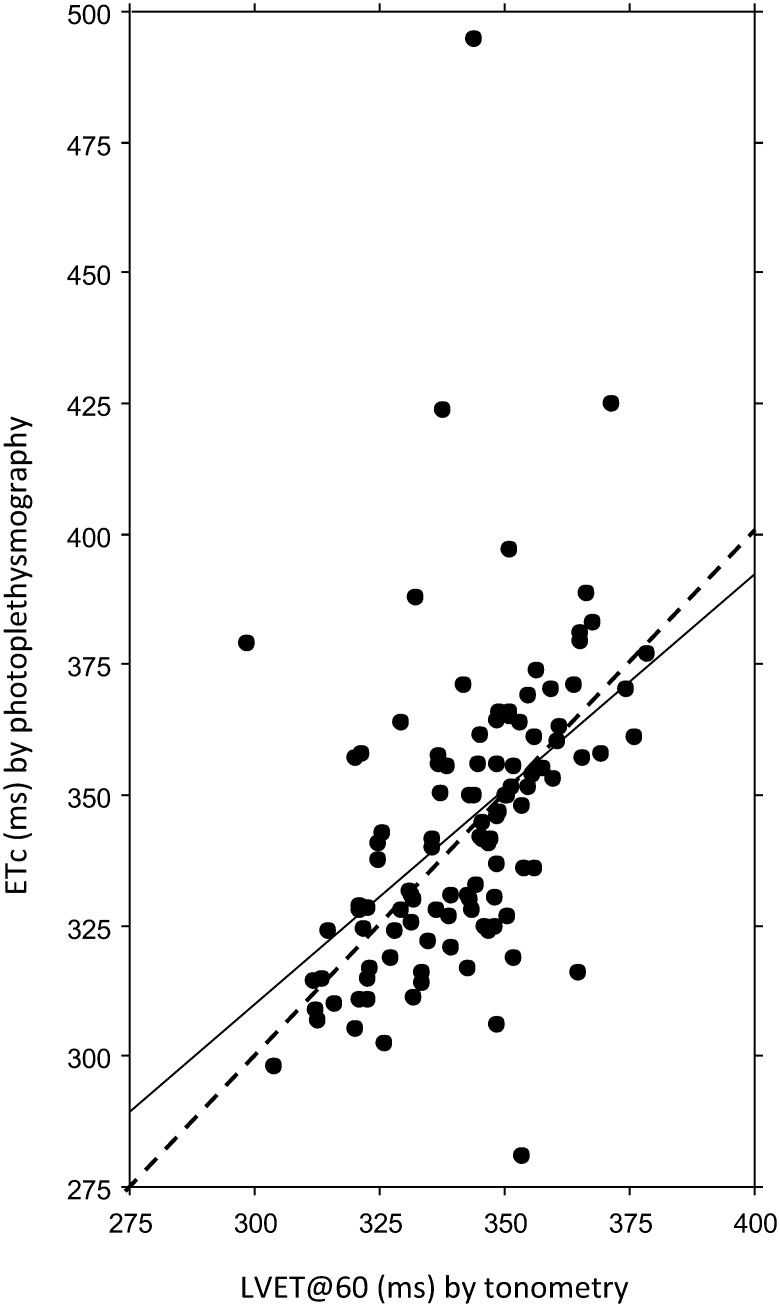
Association between ETc and LVET@60.Simple linear regression analysis of ejection time compensated (ETc) measured by photoplethysmography, and left ventricular ejection time adjusted to a heart rate of 60 bpm (LVET@60) measured by tonometry (r 0.46). The solid line represents the regression line and the interrupted line the line of identity.